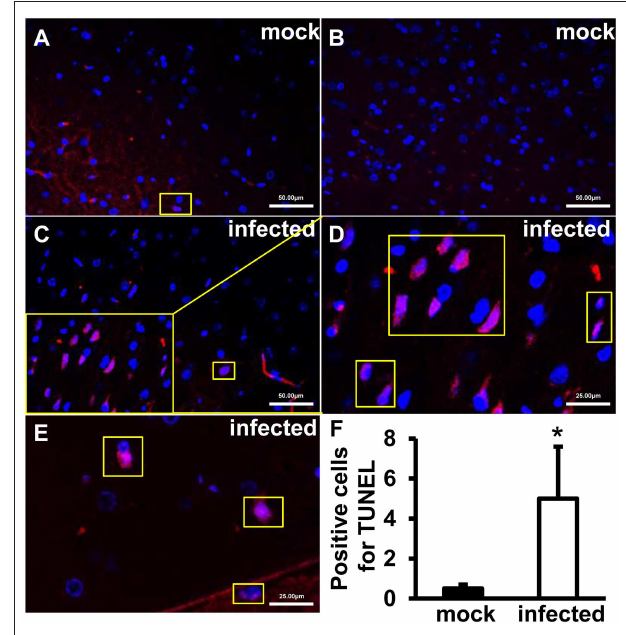
FIGURE 2 | TUNEL-positive cells increased after HEV infection. TUNEL staining of the HEV-RNA positive brain tissues collected on 14, 21, and 28 dpi was performed using in situ BrdU-Red DNA Fragmentation (TUNEL) Assay Kit and slides were counterstained with DAPI (Blue). TUNEL-positive signals merged with DAPI were shown as purple. (A,B) Few positive signals were detected in animals of mock group. (C–E) Positive signals were exhibited in infected brain sections. The high magnification images (D,E) depicted granular masses of positive signals at nucleus of the apoptotic cells. (F) TUNEL-positive cells were significantly increased in HEV-infected gerbil brain tissues (* p <